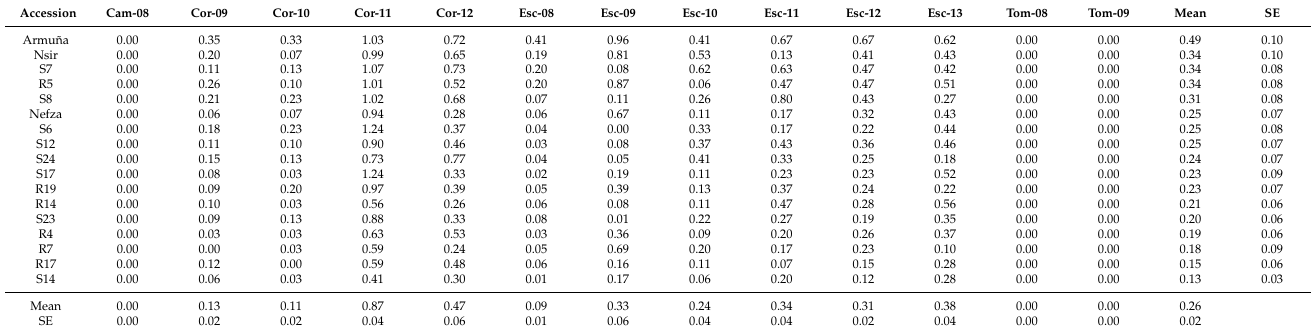
Table 6. Mean broomrape infection (Oc/plant) of 17 lentil accessions grown at 13 location–year environments.